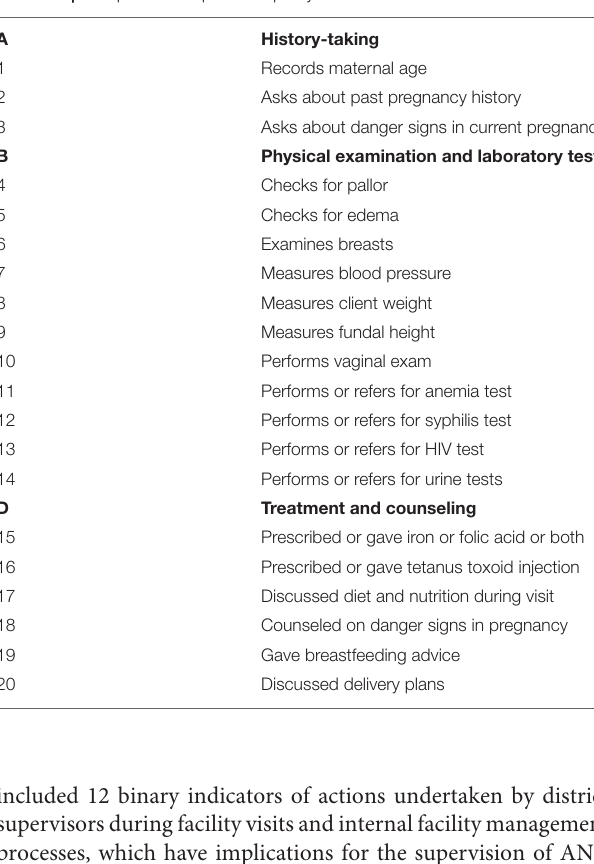
TABLE 3 | Components of process quality index. TABLE 4 | Components of equipment and infrastructure